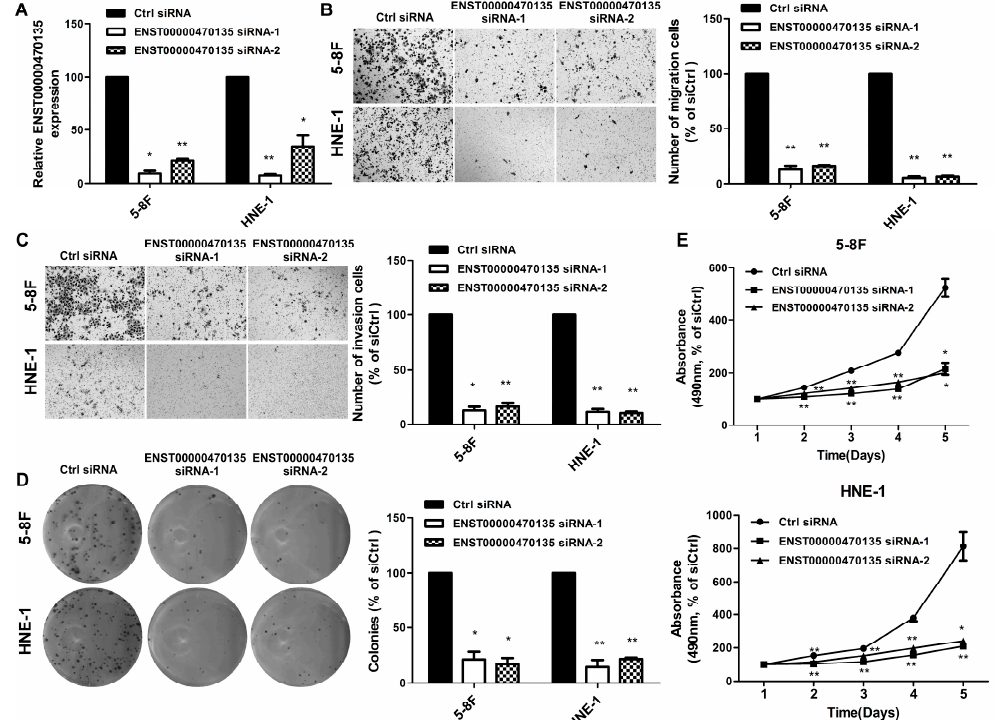
Figure 5. Effects of ENST00000470135 depletion on NPC cell migration, invasion and proliferation in